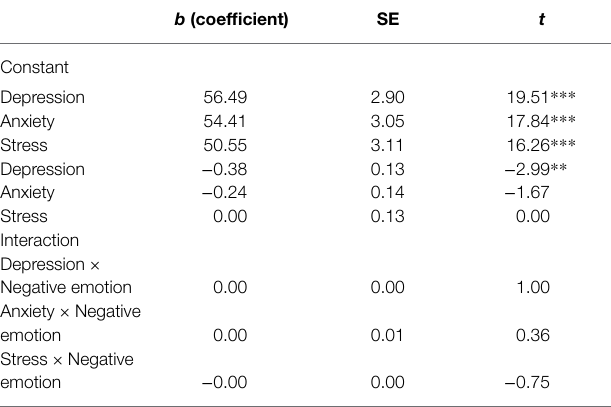
TABLE 6 | The moderation effect of negative emotion on the relationship between depression, anxiety, and stress on psychological wellbeing. b (coefficient) SE